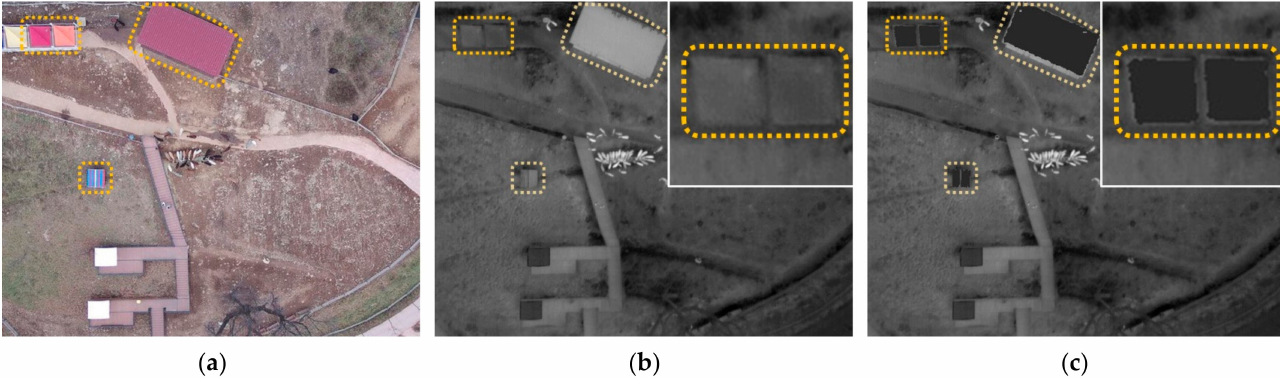
Figure 6. Example of thermal image correction (unnatural). ( a ) Original RGB image, ( b ) original thermal image, and ( c ) corrected thermal